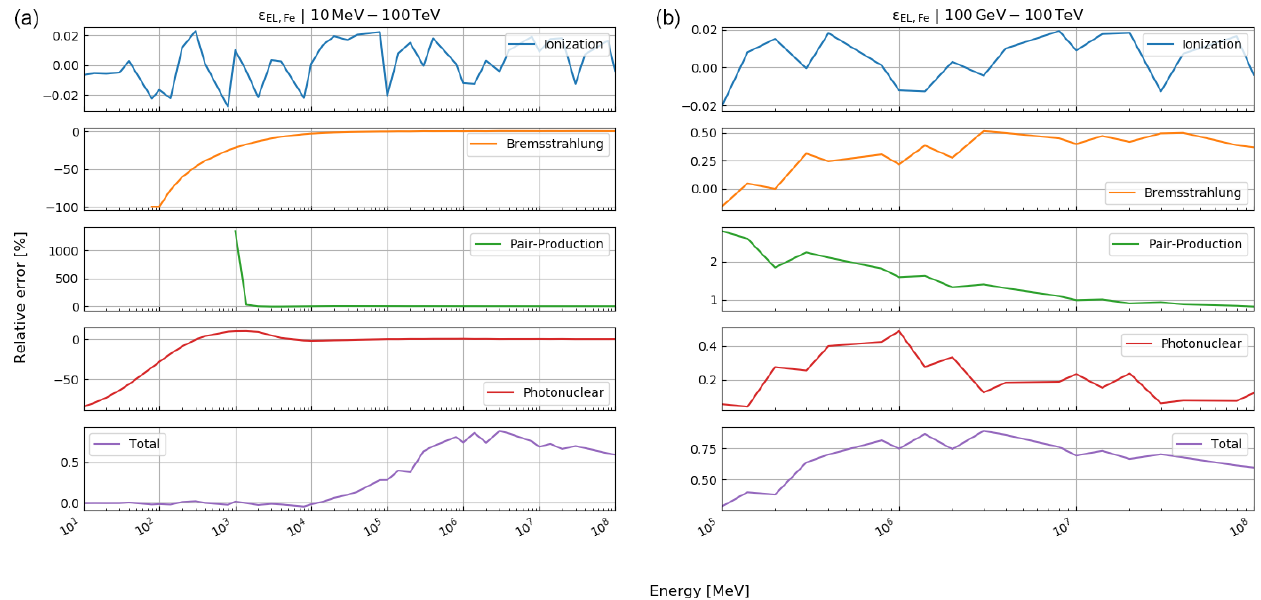
Figure E8. Relative error of our energy loss calculations compared to the tabulated values from Groom et al. (2001) for iron in the energy